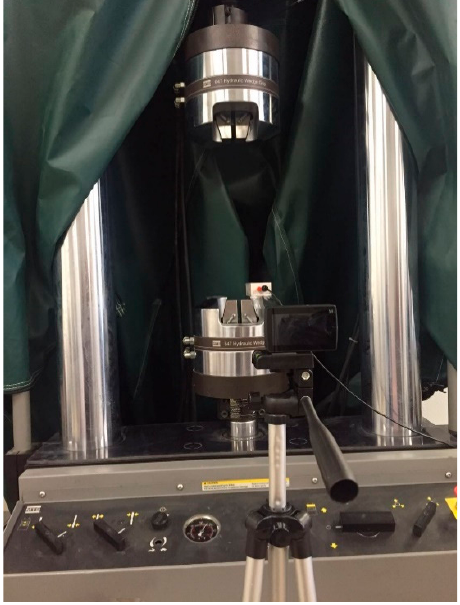
Figure 5. Set-up for lab experiment.